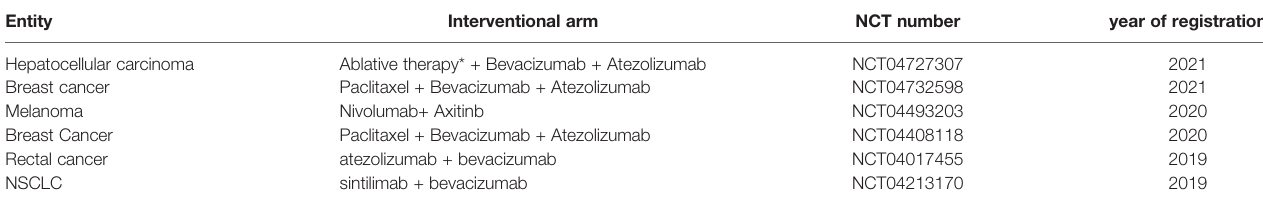
TABLE 1 | overview of some currently recruiting clinical trials investigating anti-angiogenic therapy in conjunction with cancer immunotherapy. Entity Interventional